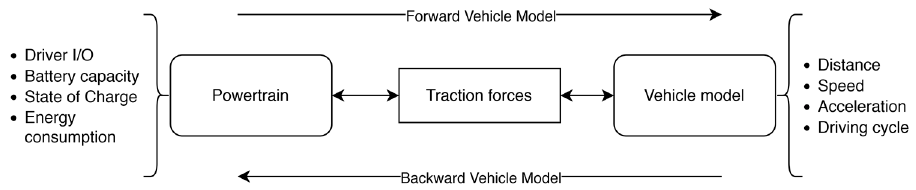
Figure 2. Block diagram of forward and backward vehicle models.